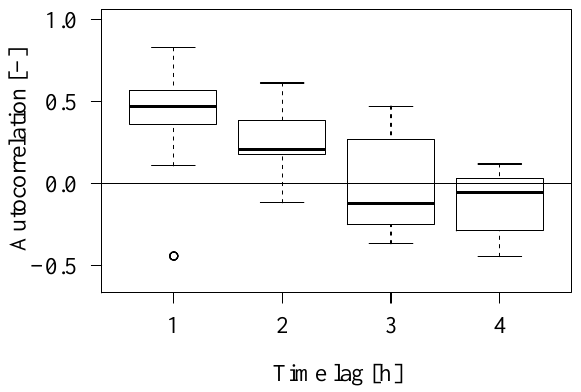
Fig. 2. Autocorrelation coefficients of the catchment averaged pre- cipitation of the Upper Ourthe for 30 rainy events between 1 Oc- tober 2002 and 31 March 2003. The bold black line in the boxplot is the median, the body of a boxplot shows the interquantile range (Q75–Q25) and the whiskers represent the sample minima and sam- ple maxima, unless the extreme value occurs further than 1.5 times the interquartile range from the box, in which case the outlier is shown by a